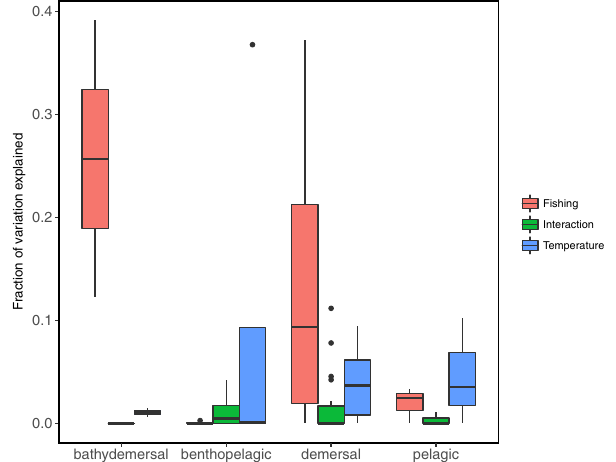
Figure 3. Boxplot showing the variation of size structure explained by the fishing, temperature, and interactive effect grouped by the habitat of species. Particularly, the fraction of variation explained by fishing is significantly different from both temperature ( P = 0.0014) and interaction ( P = 7.5 × 10 − 5 ) for demersal species.